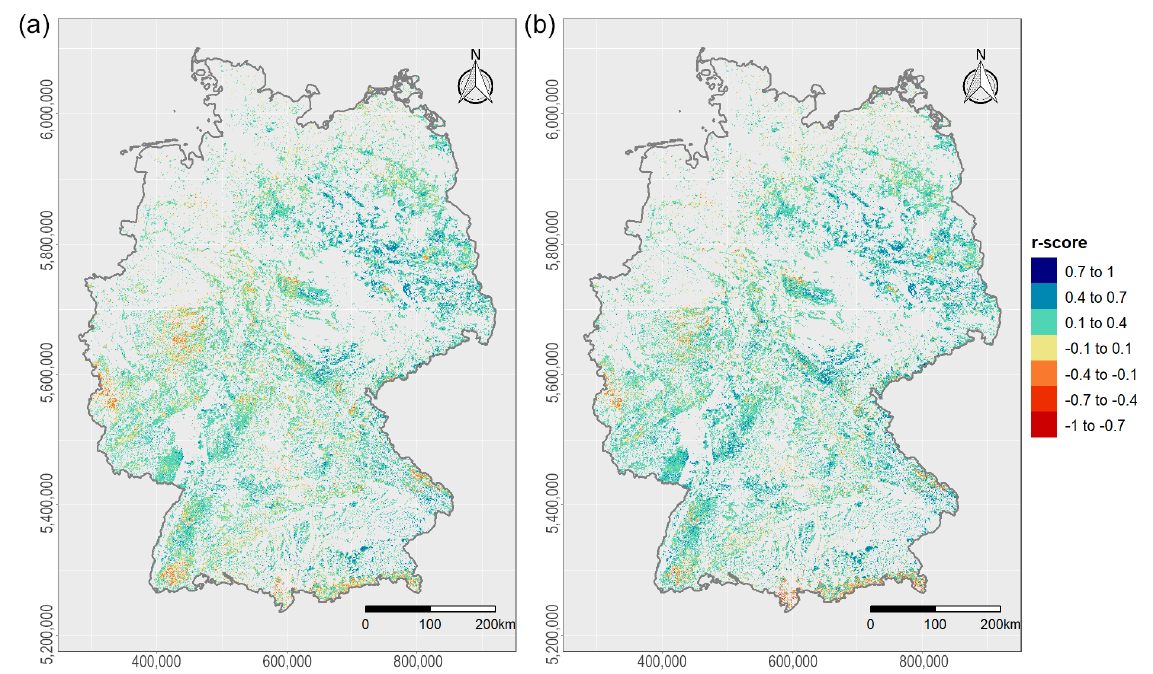
Figure 7. Spatial variability of correlation coefficients between scPDSI and ( a ) MODIS NDVI ∆ Harmonic as well as ( b ) MODIS NDVI z-score values across German forest areas.